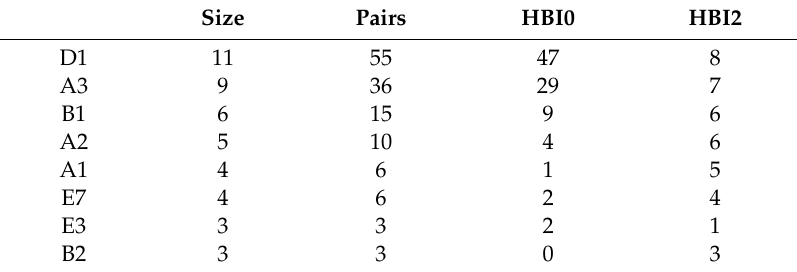
Table 5. Measurement values of the honest broker indices. Size Pairs HBI0 HBI2 D1 11 55 47 8 A3 9 36 29 7 B1 6 15 9